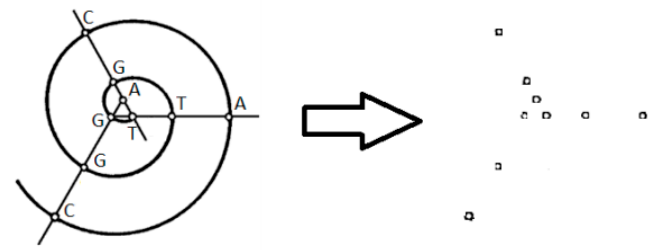
Figure 2. Transformation of Archimedean coordinates to Cartesian coordinates.